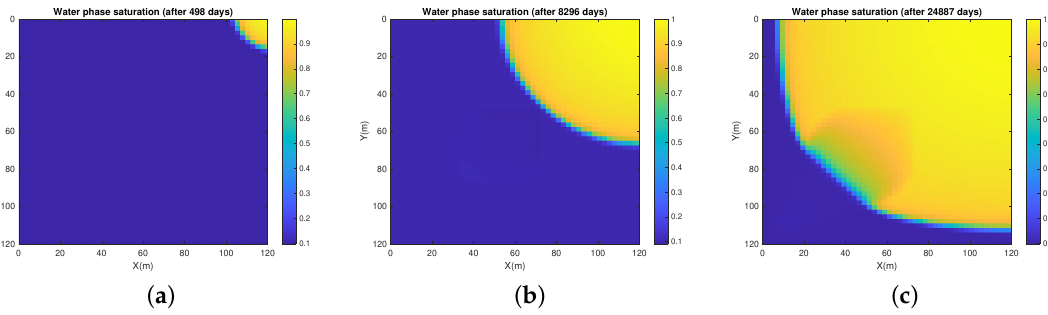
Figure 11. Water saturation at different time for Example 3: ( a ) Water saturation (after 498 days). ( b ) Water saturation (after 8296 days). ( c ) Water saturation (after 24,887